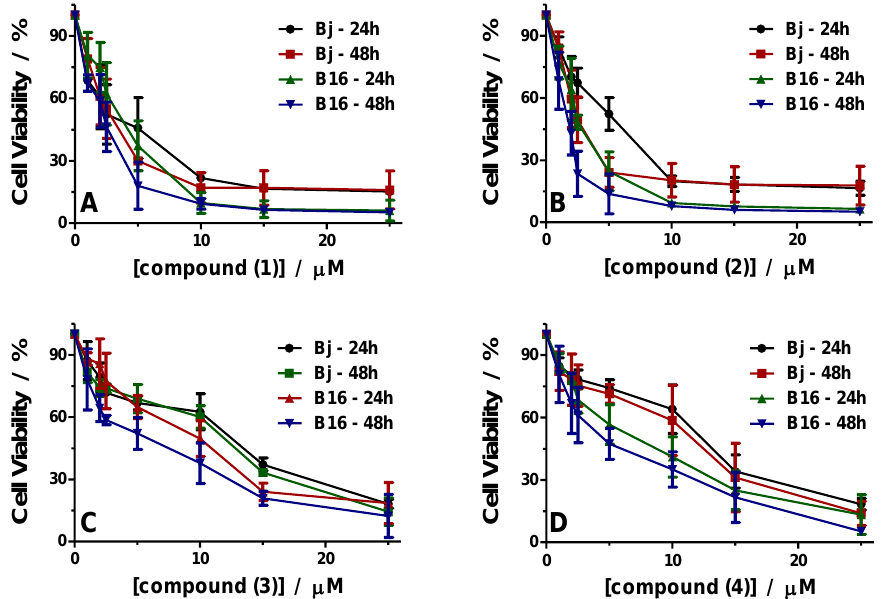
Figure 8. Cell viability of the complexes against BJ and B16 cells after 24 and 48 h for complex ( 1 ) ( A ), complex ( 2 ) ( B ), complex ( 3 ) ( C ), and complex ( 4 ) ( D ). Data represent the means ± SD of at least three independent tests.